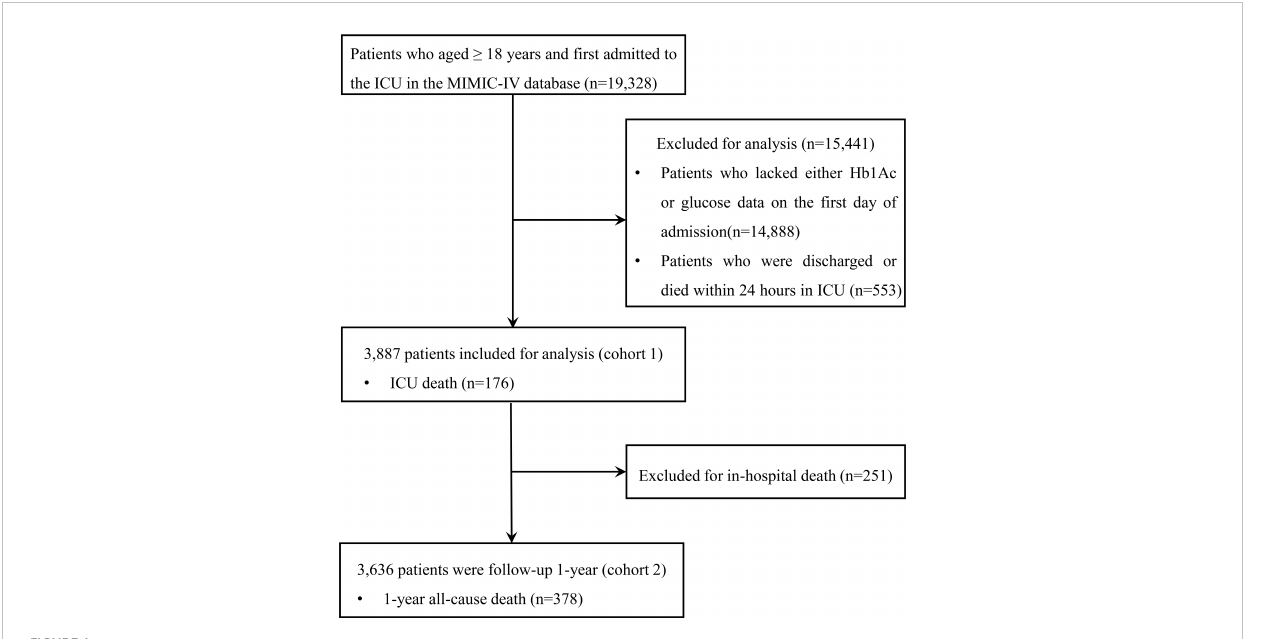
FIGURE 1 Flow chart of the study. ICU, intensive care